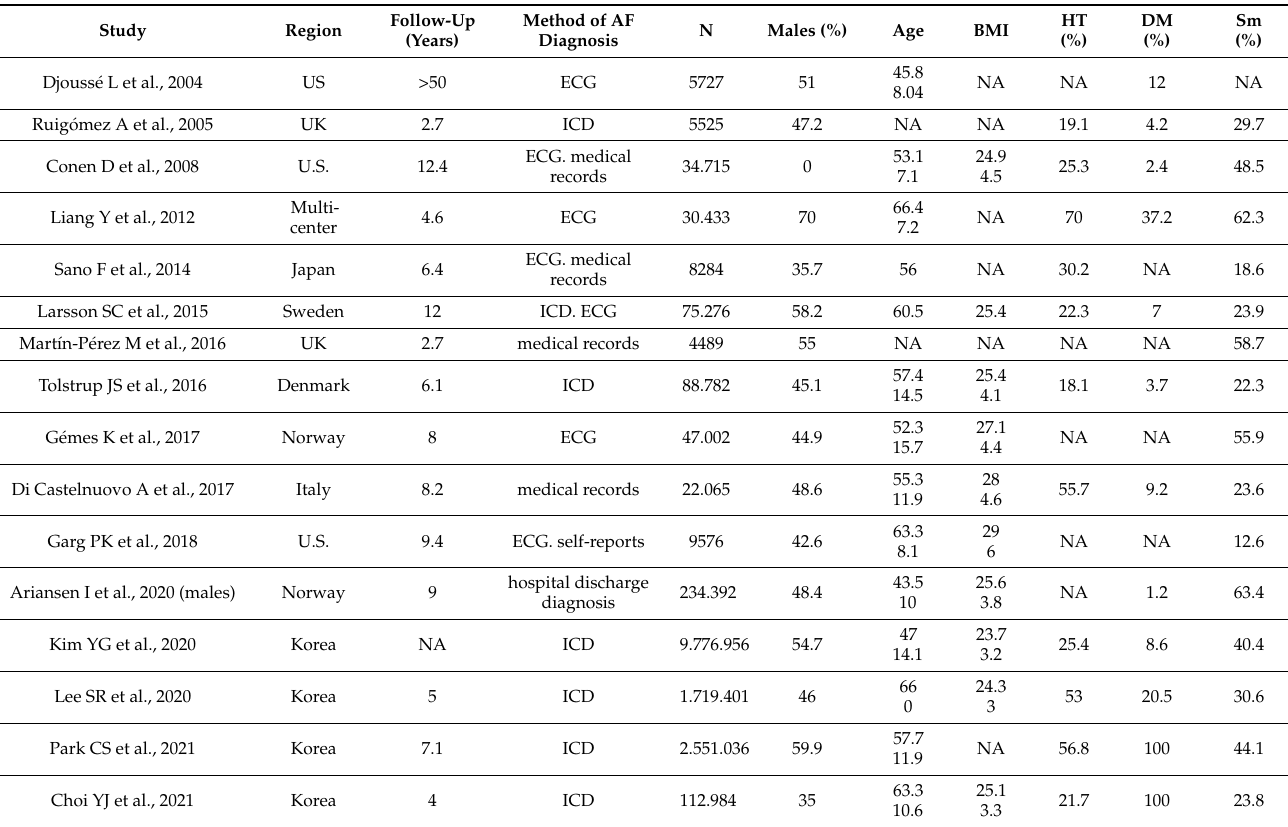
Table 1. Characteristics of the included